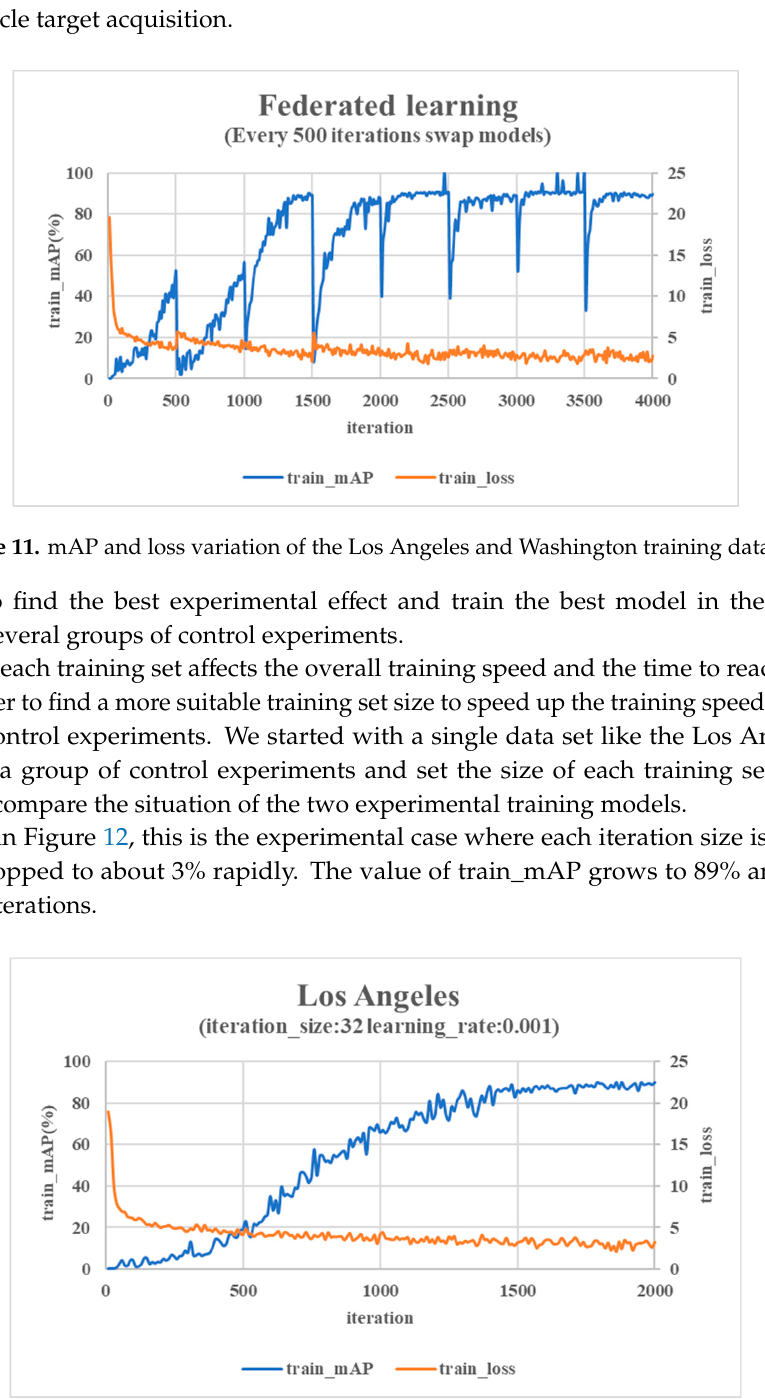
Figure 12. mAP and loss variation of the Los Angeles training data set when the size of each training set is 32.